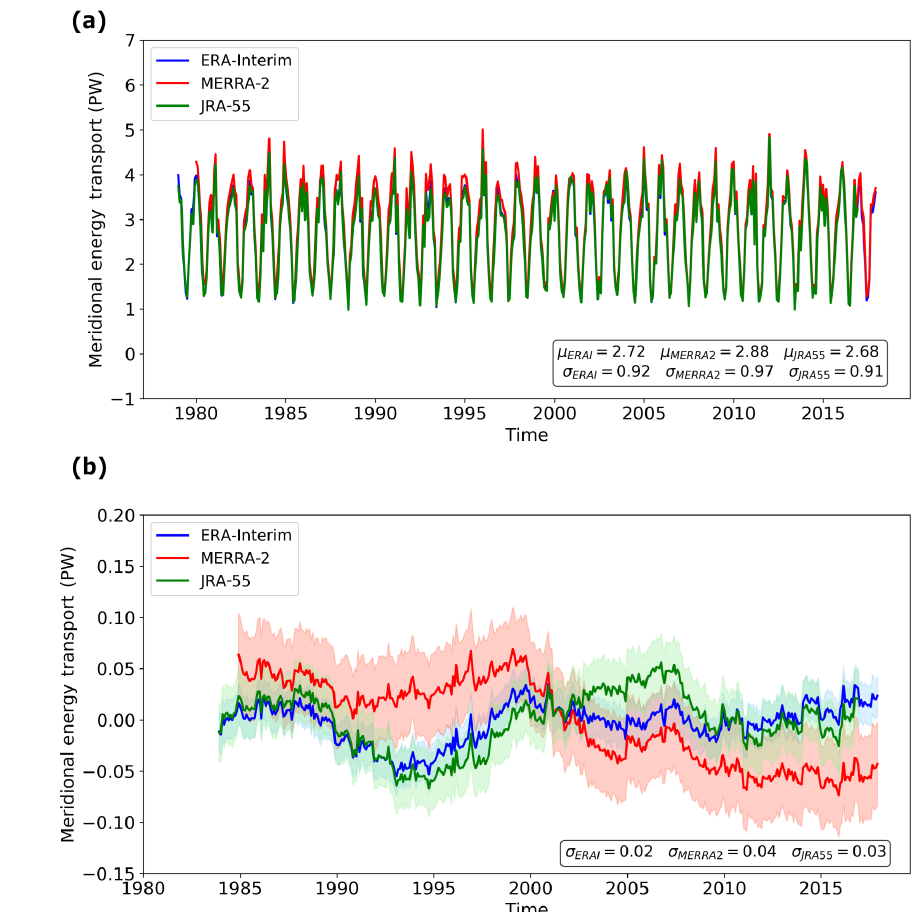
Figure 3. Time series of zonal integral of AMET at 60 ◦ N without/with a low-pass filter. (a) The original time series and (b) the ones with a low-pass filter include signals from ERA-Interim (blue), MERRA-2 (red) and JRA-55 (green). For the low-pass-filtered ones, we take a running mean of 5 years. The shades represent the confidence intervals with 1 standard deviation. σ is the standard deviation and µ is the mean of the entire time